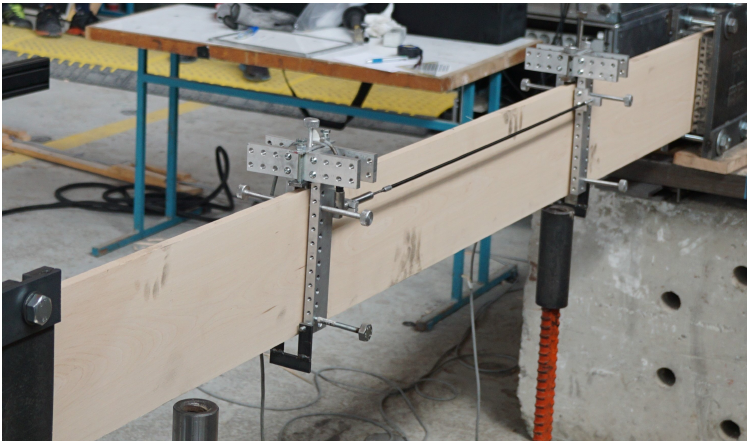
Figure 1. LVDT setup for static MOE measurement during tensile